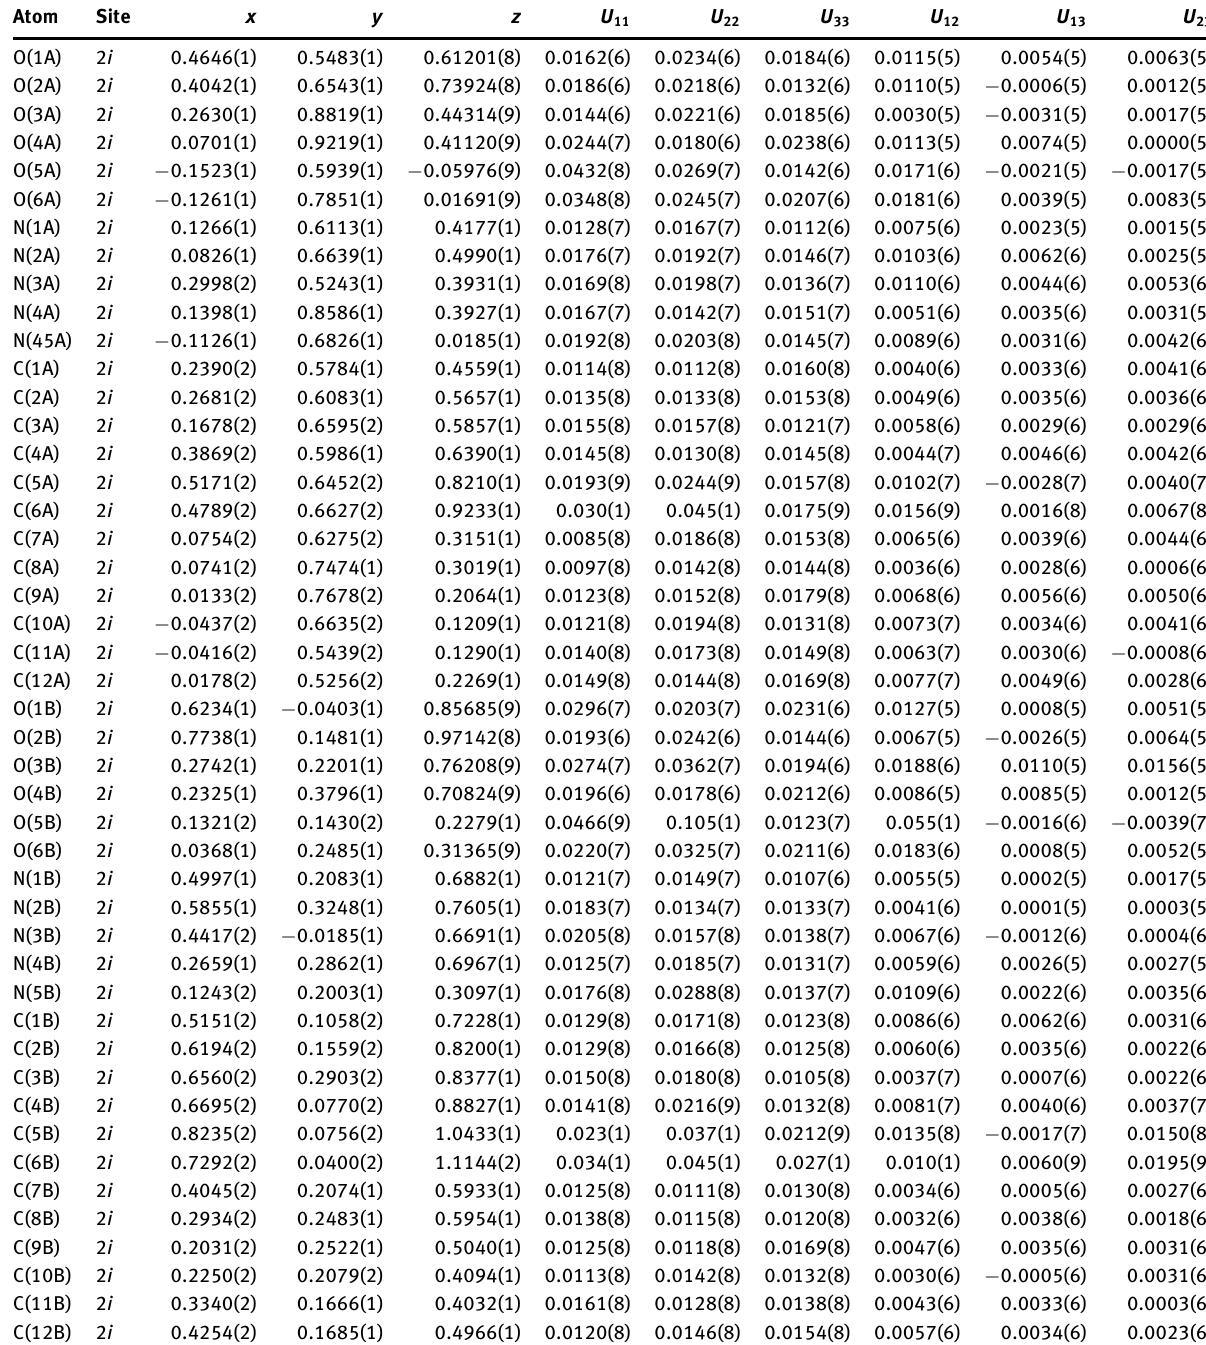
Table 3: Fractional coordinates of atomic displacement parameters (Å 2